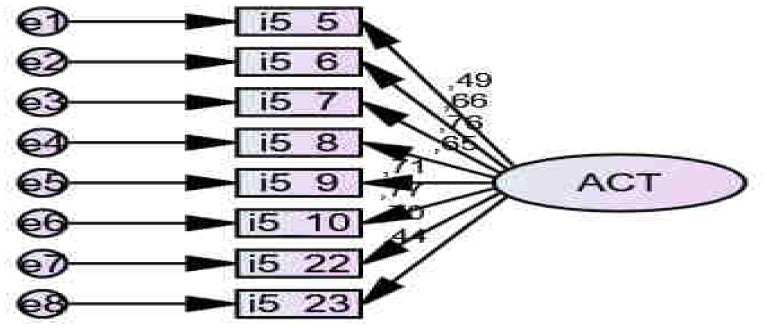
Confirmatory Factor Analysis (CFA) of Attitudes scale.